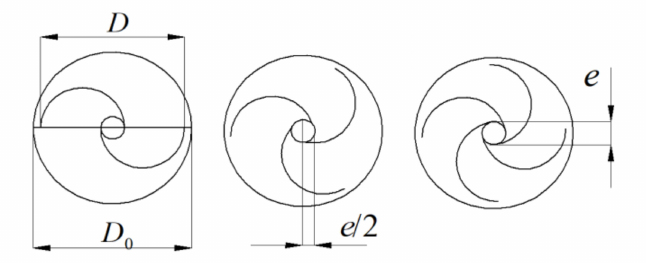
Figure 7. Rotor models used in the experimental research [73]. According to the experimental results obtained, the four-blade rotor had the highest CP value at a TSR of 0.37 or wind speed of 6 m/s. After this value, the four-blade rotor had a decreasing rotational speed, which affected its energy efficiency. The three-blade rotor had better performance than the four-blade rotor at wind speeds between 7 and 10 m/s, an interval in which it recorded better power values than the analyzed models